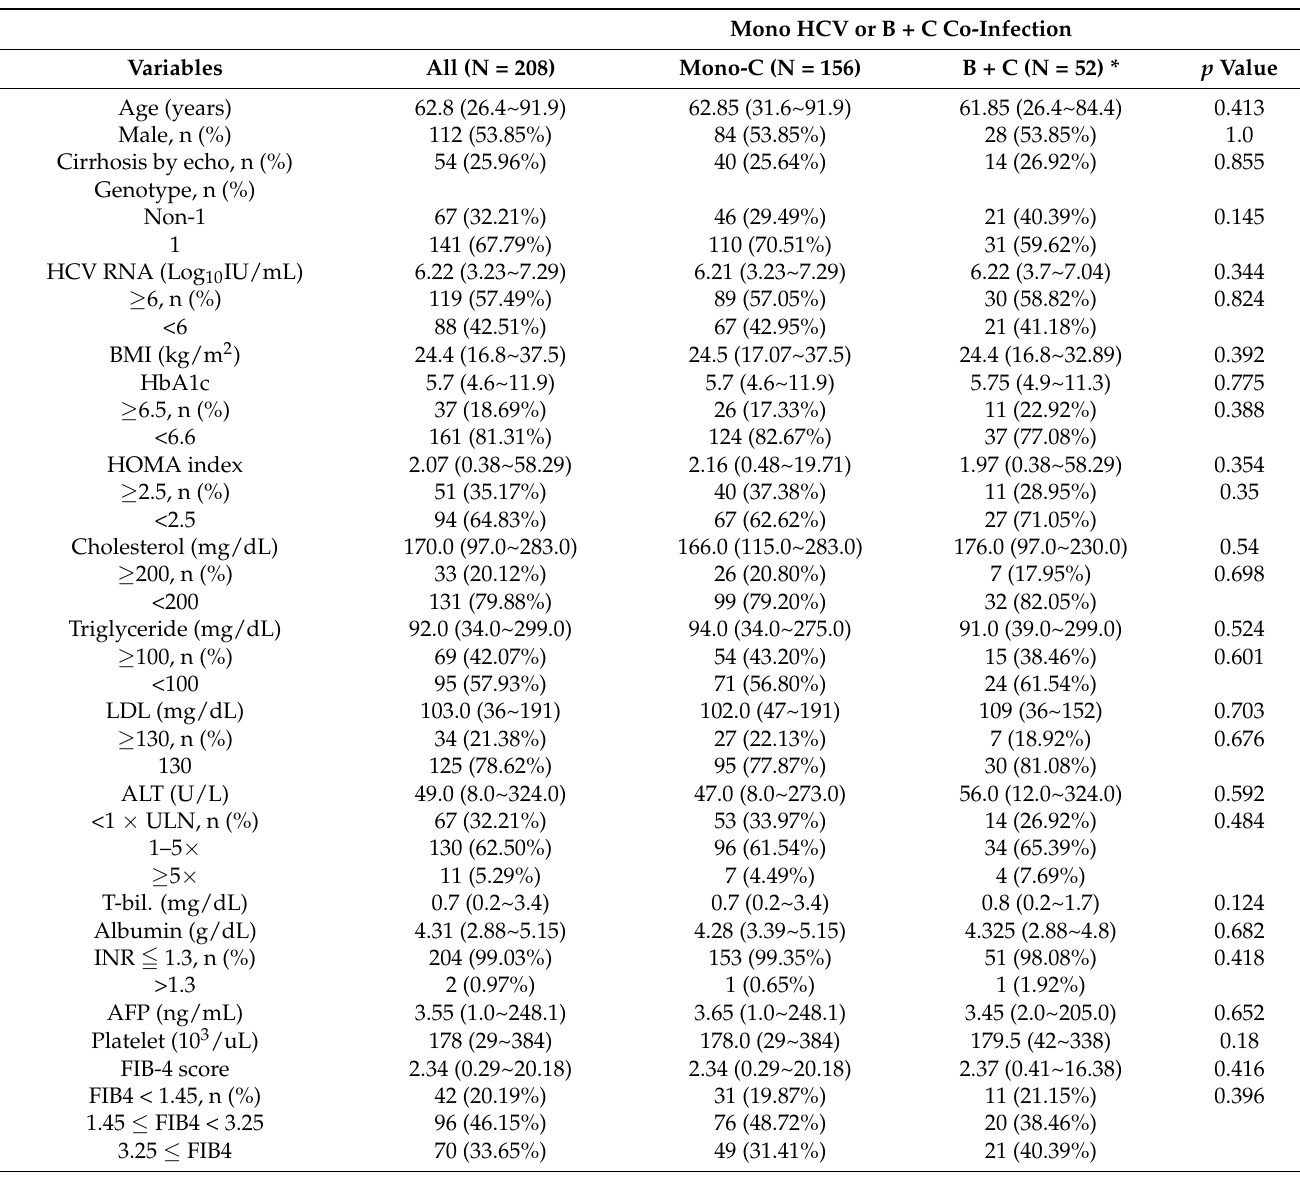
Table 3. Pretherapy demographic comparison after PSM (1:3 match, n = 208). Mono HCV or B + C